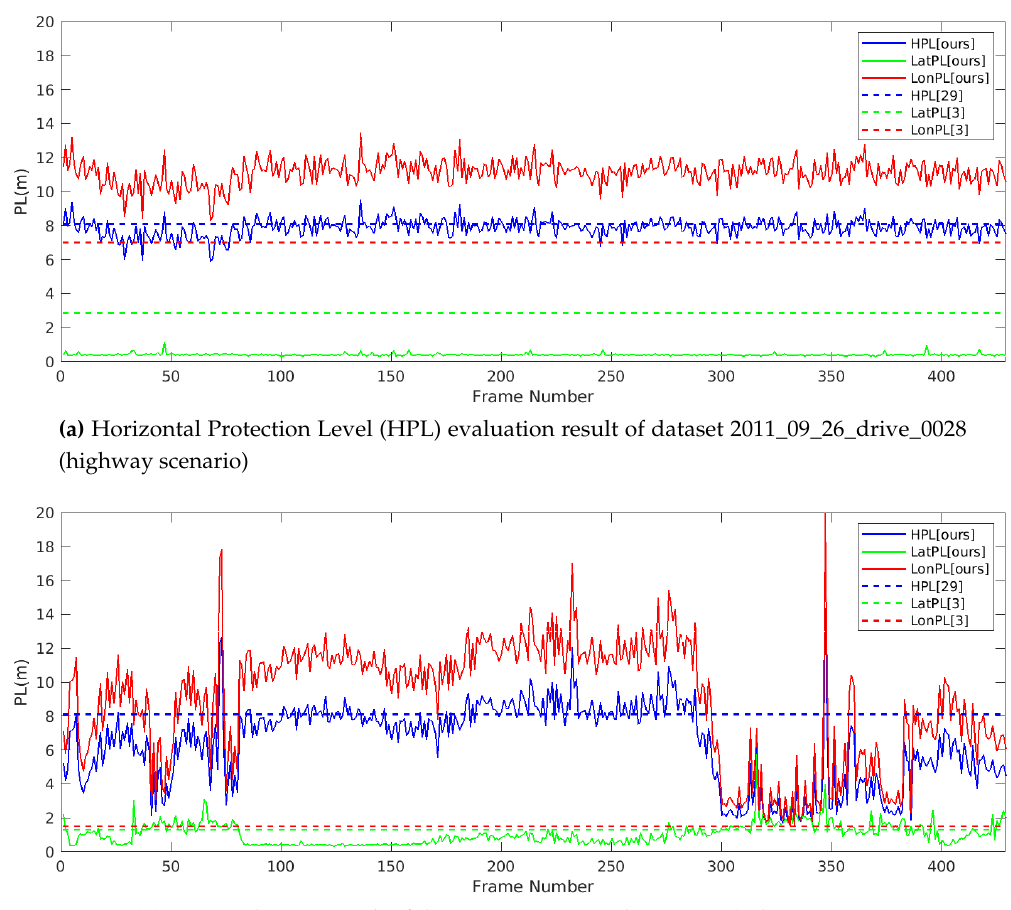
Figure 9. Horizontal Protection Level (HPL)